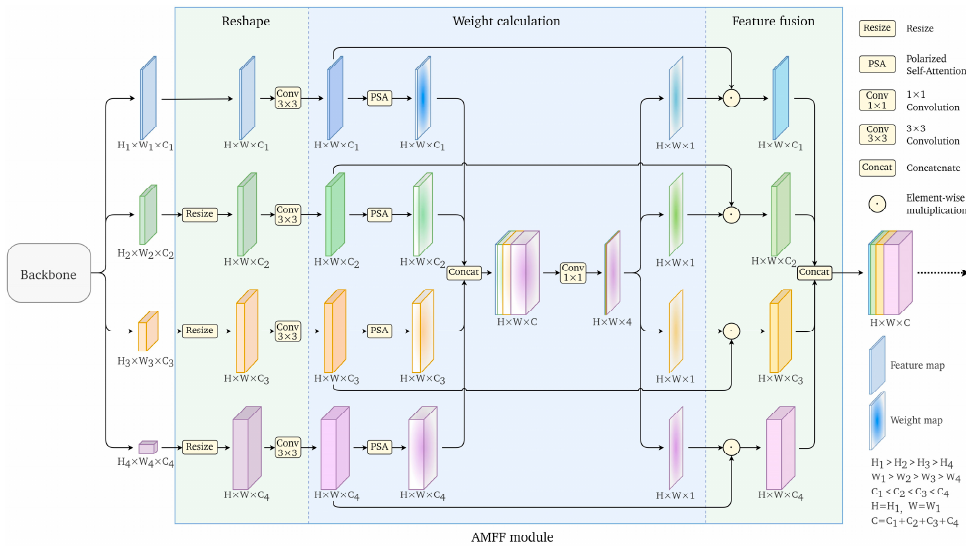
Figure 2. Schematic diagram of the AMFF module structure. The attention mechanism facilitates adaptive adjustment of the weights of the distinctive features.